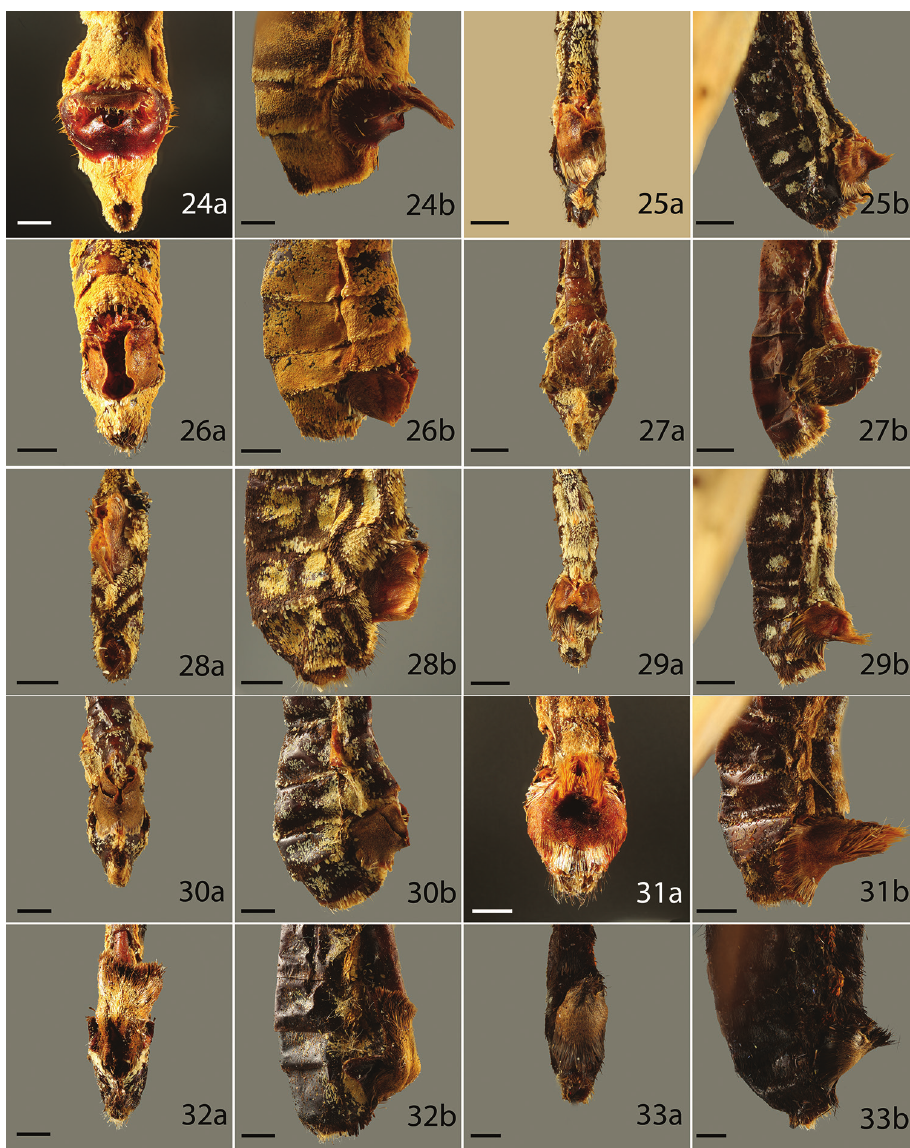
Figures 24–33. Sphragis of butterfly species, a ventral b lateral, category of the sphragis in